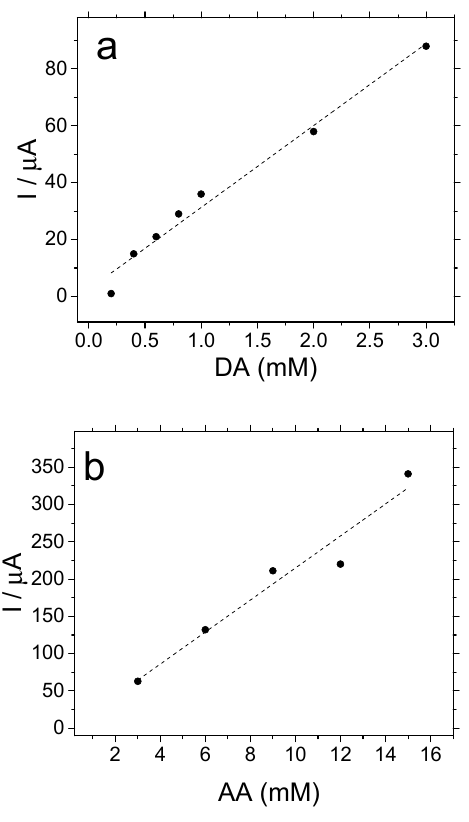
Figure 8. Peak oxidation currents recorded for a Pt electrode covered with a piperazine–aniline copolymer in 1 M of HClO 4 aqueous solutions containing an increasing concentration of analyte: ( a ) dopamine; ( b ) ascorbic acid.